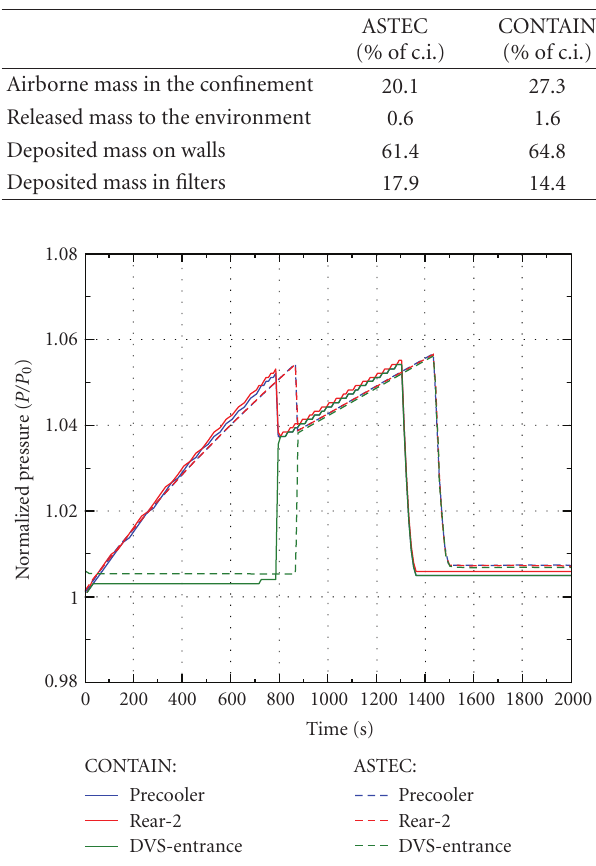
Figure 8: Pressure evolution in the main confinement compart- ments for the SB